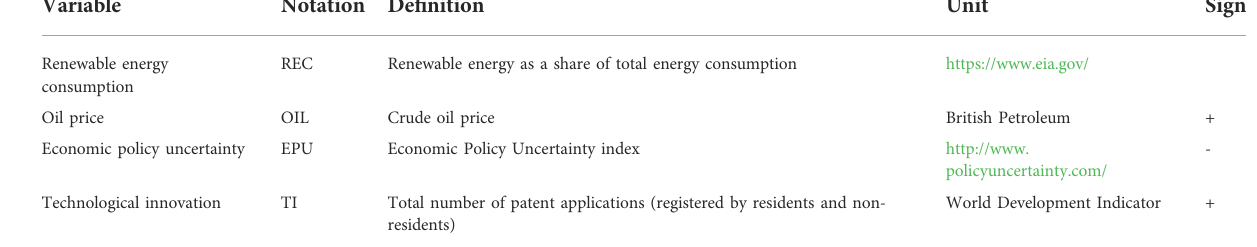
TABLE 1 Proxy measures of research variables.